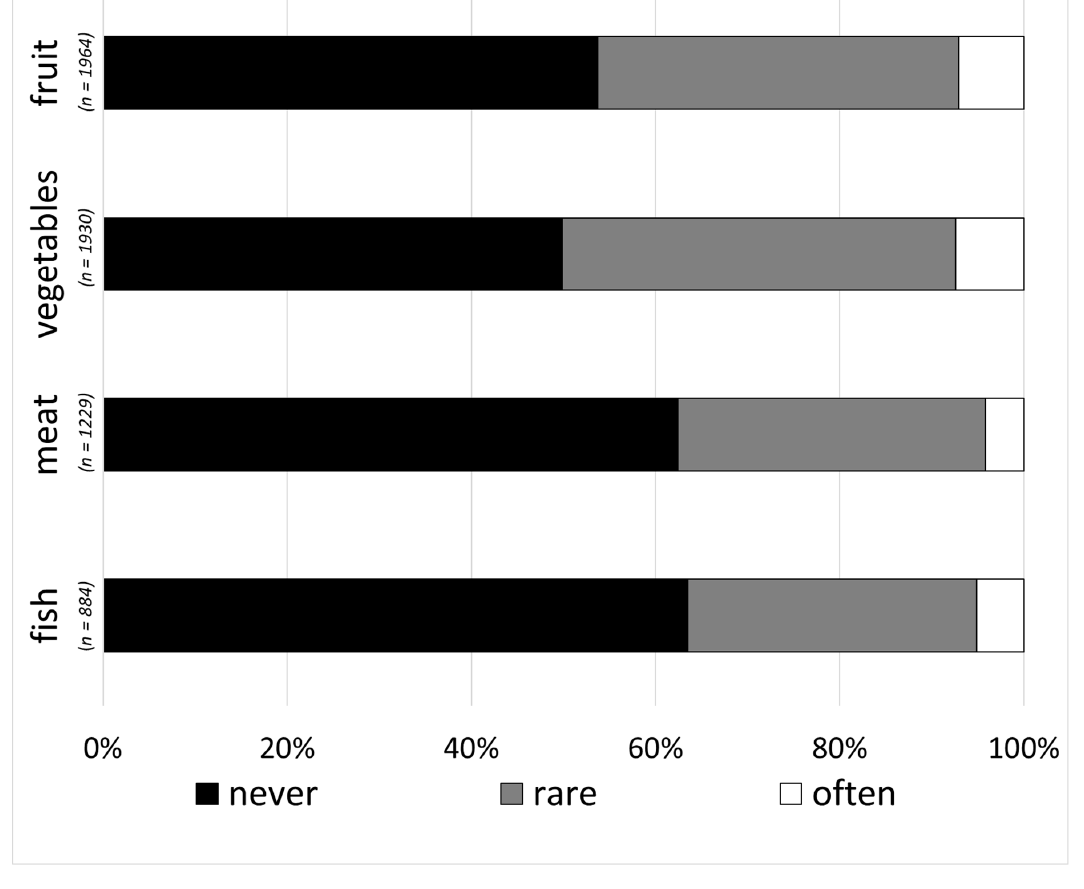
Figure 3. Frequency of respondents’ loss of freshness of fruit, vegetables, meat and fish (multiple-choice, single-answer).